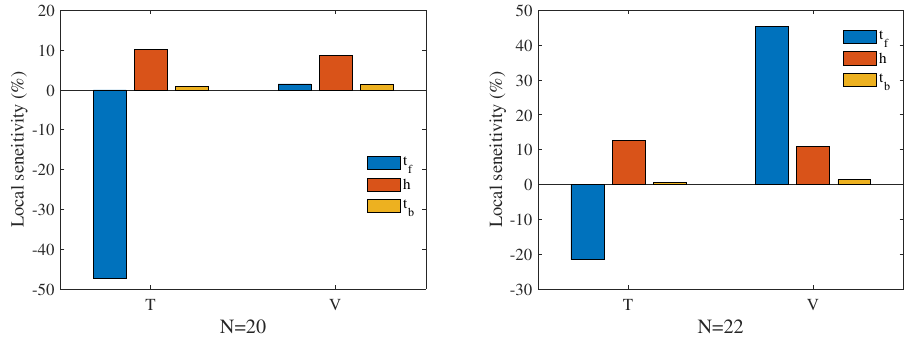
Figure 7. Local sensitivity of T and V to structural parameters.